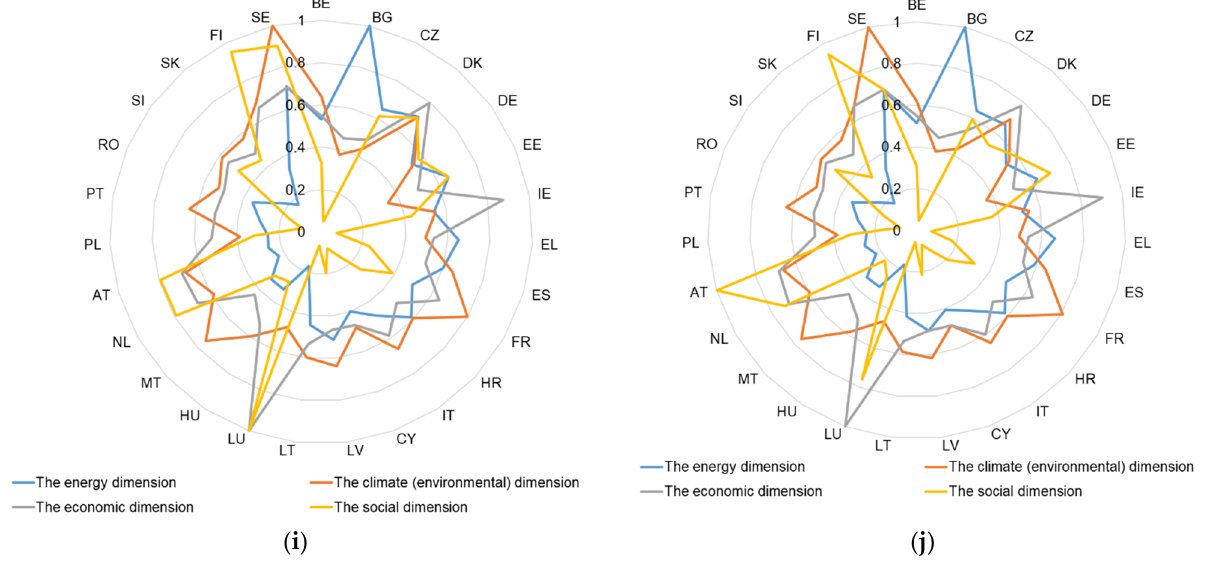
( i ) ( j ) Figure 6. The value of the P i index for the studied EU countries and for individual dimensions in the studied period ( a —